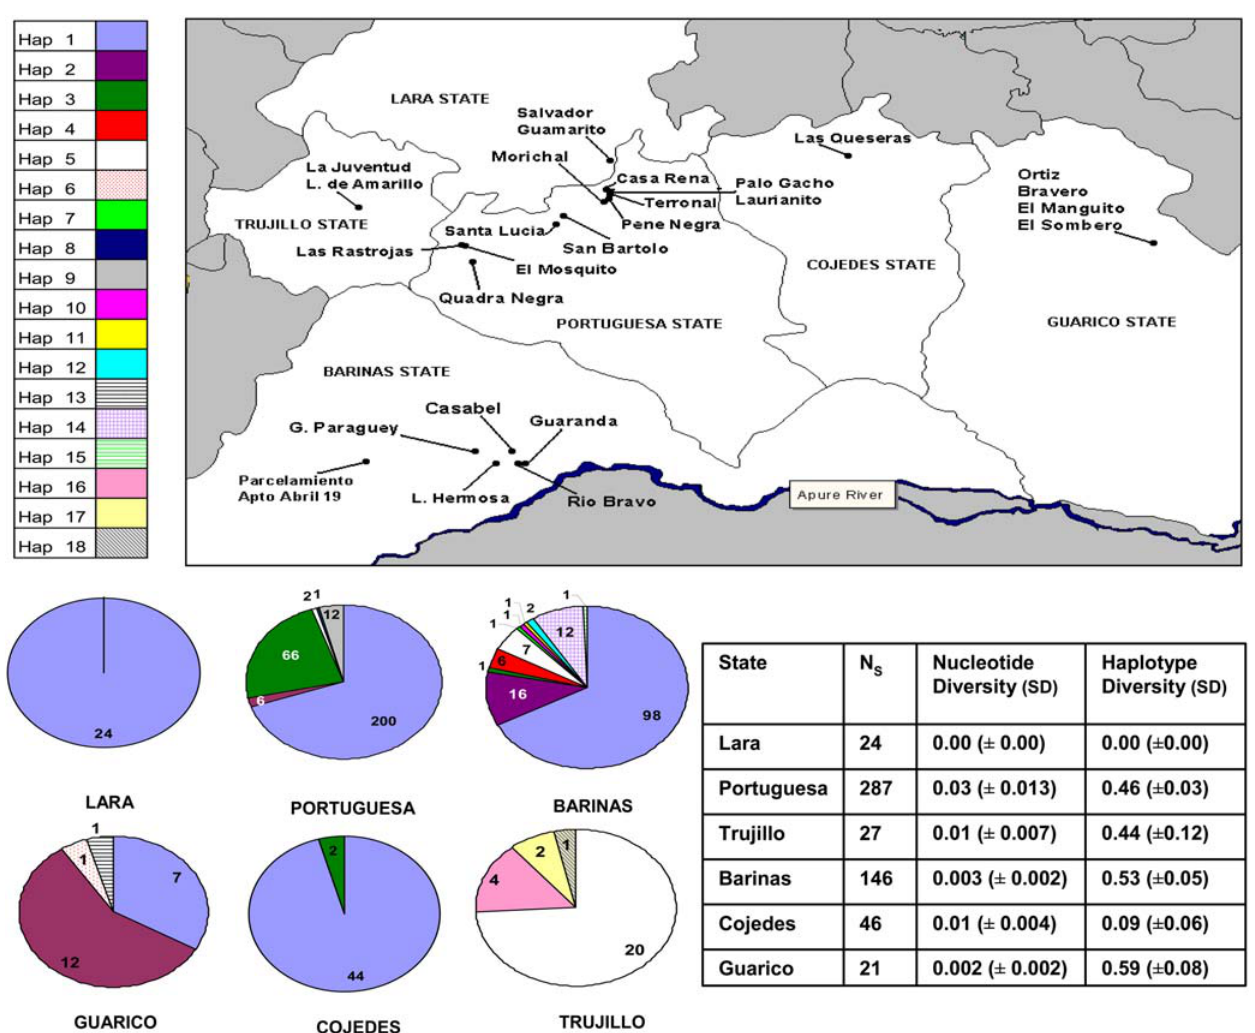
Figure 1. Genetic diversity (table) and haplotype distribution (pie charts) in the sampled States. The map illustrates 27 of the sampled localities in this study.